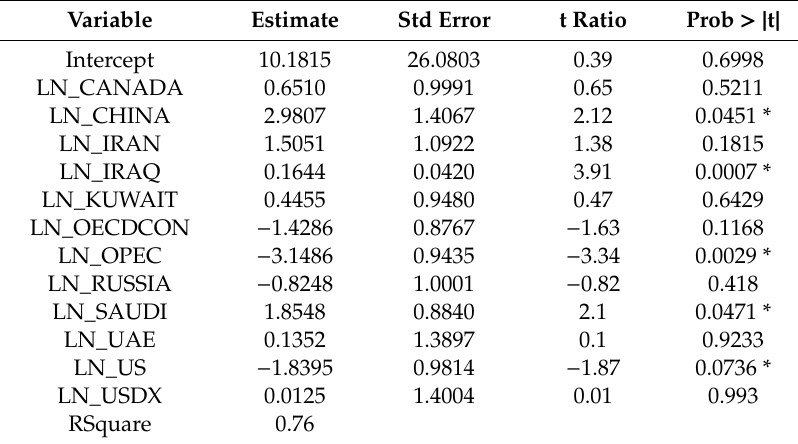
Table 8. Panel 2 period (2001–2003): LN_BRENT prediction-parameter estimation.